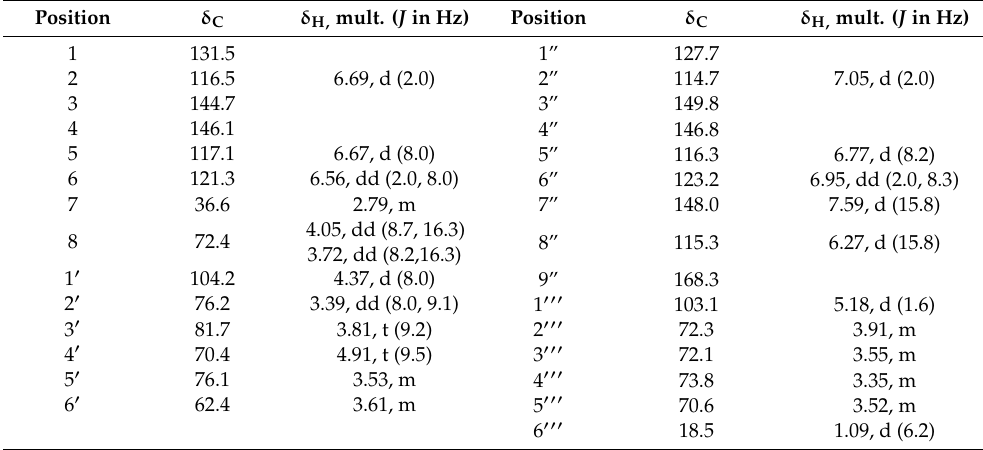
Table 1. 1 H and 13 C-NMR spectroscopic data of verbascoside ( 1 ) in CD 3 OD.